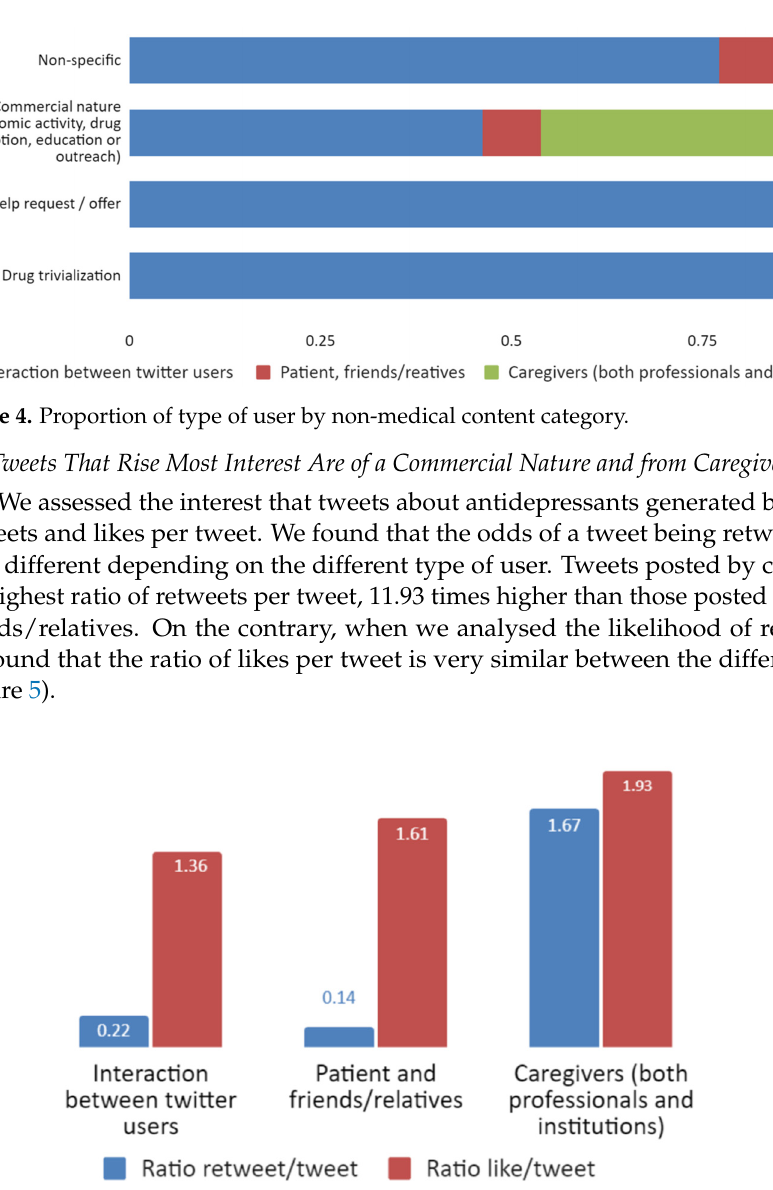
Figure 5. Retweet and like ratio ( Y -axis) by type of user ( X -axis).